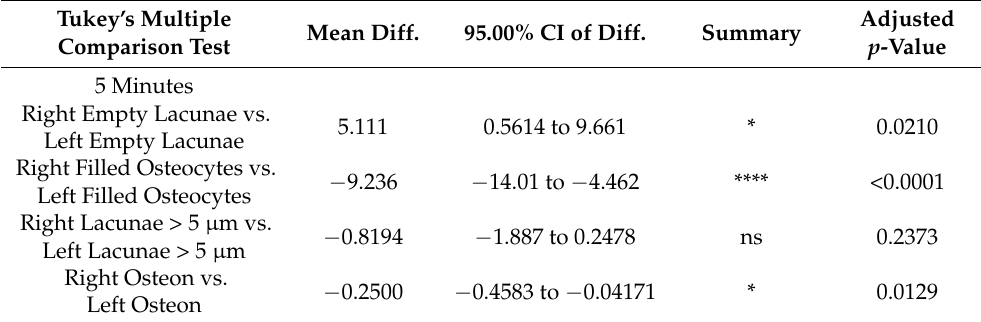
Figure 11. Left and right 5 min implant inter-group comparison graph. Table 9. Left and right 5-min implant inter-group comparison table.